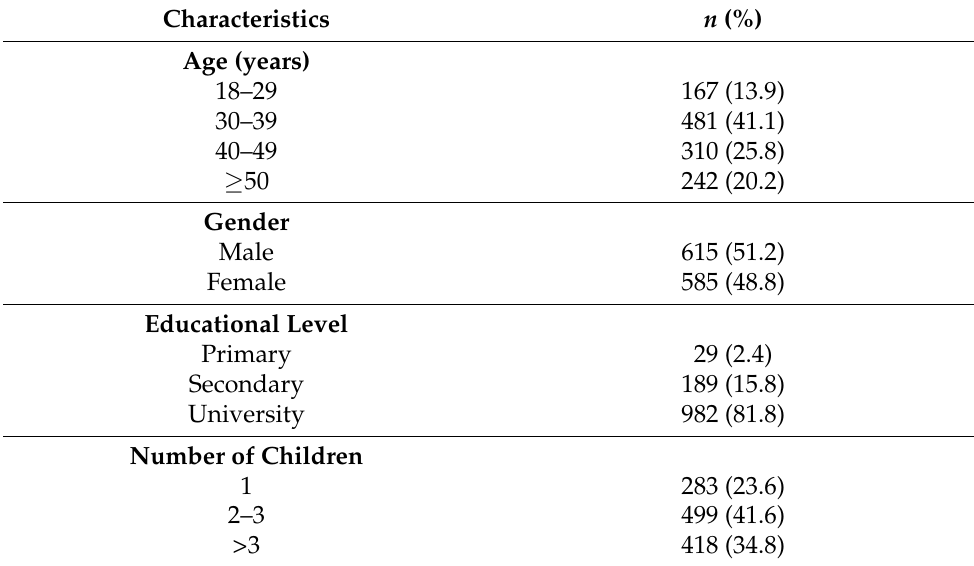
Table 1. Socio-demographic characteristics of Saudi parents ( N =